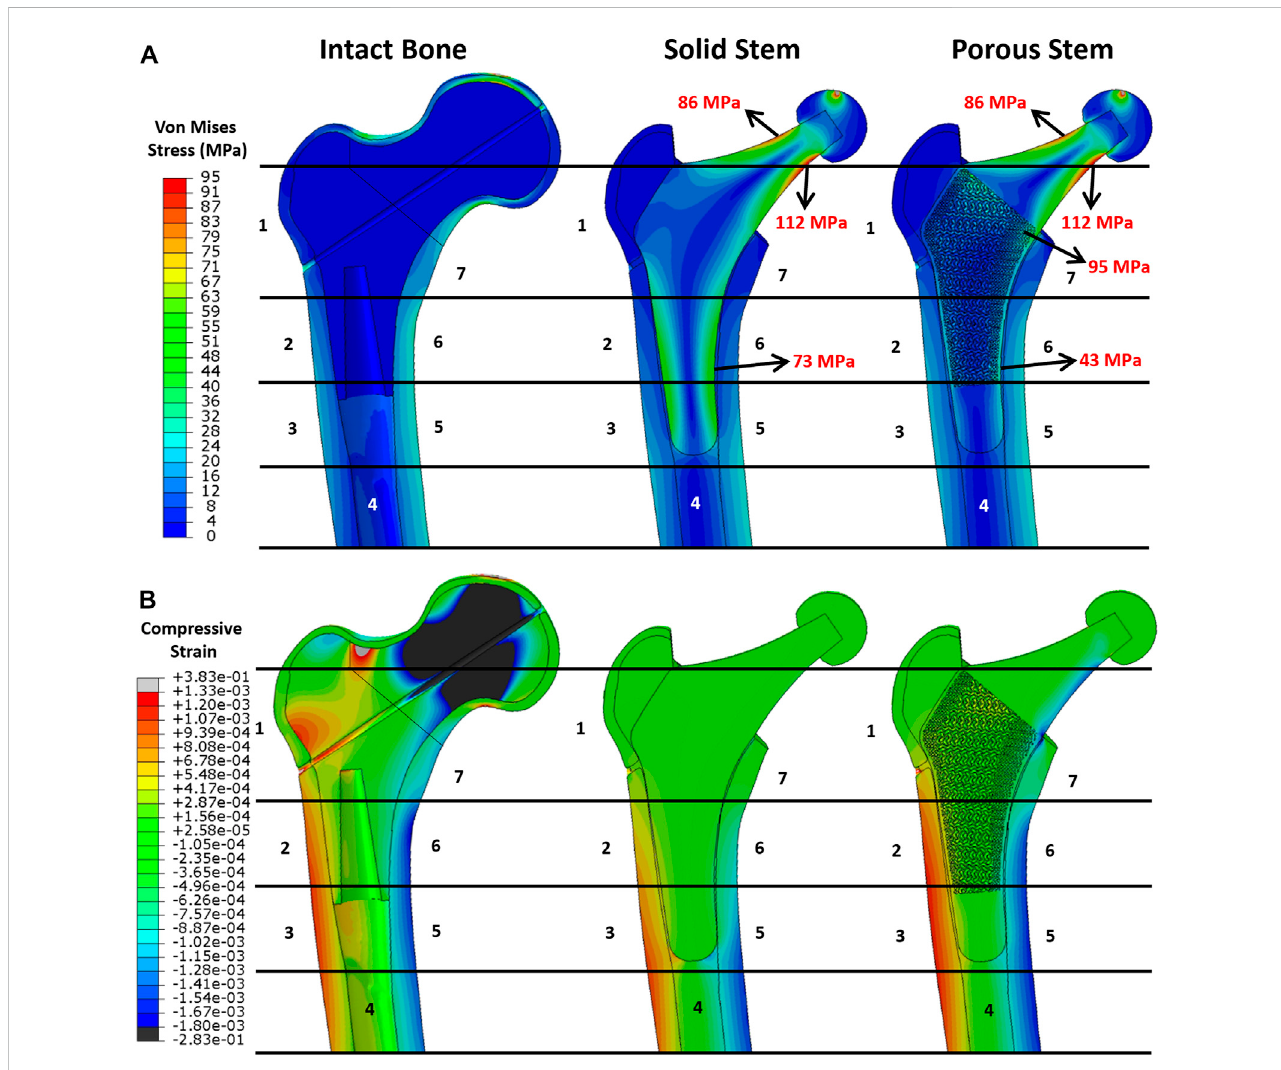
FIGURE 7 FEA results. Pattern of (A) von Mises stress and (B) compressive strain distribution across the intact bone and the implanted femur with solid and porous stems at 2,300 N